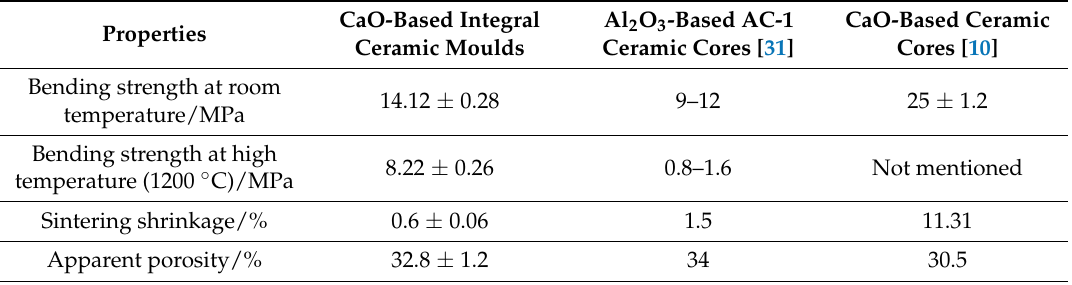
Table 2. Properties of CaO-based integral ceramic mould, Al 2 O 3 -based AC-1 ceramic cores and CaO-based ceramic